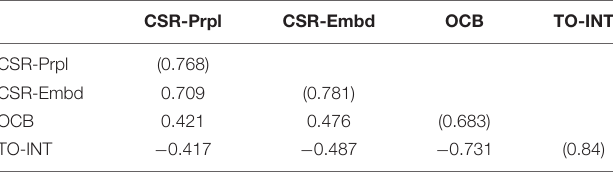
TABLE 2 | Discriminant validity results for different